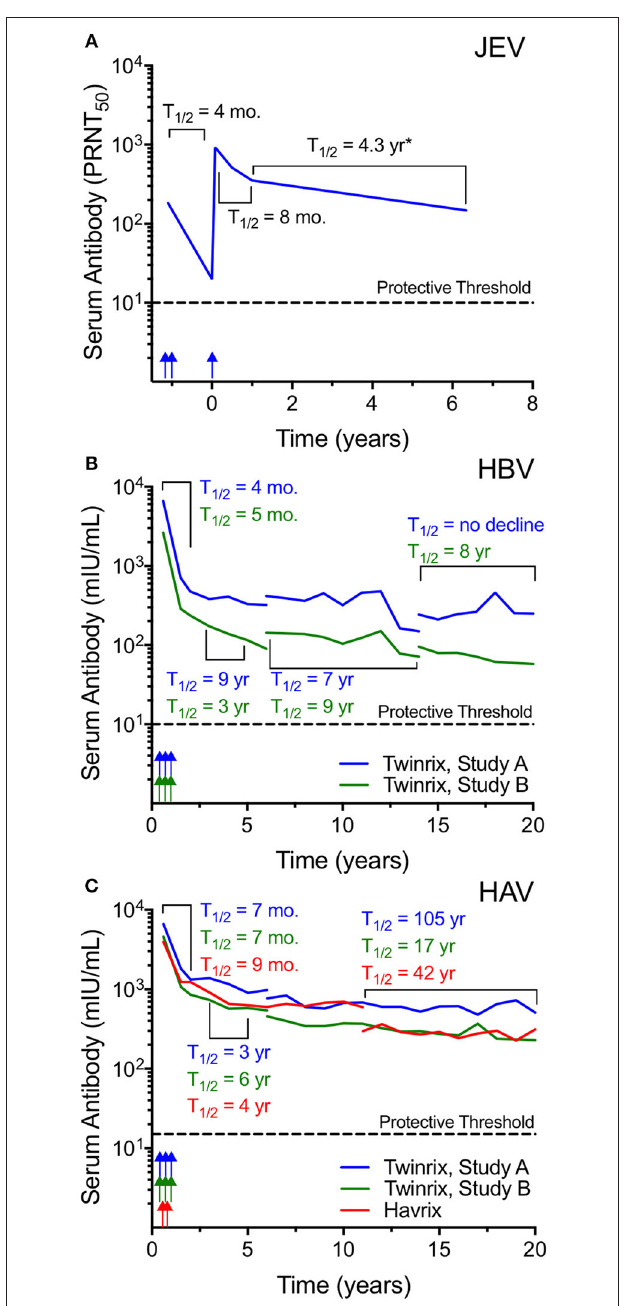
FIGURE 2 | Inactivated whole-virus vaccines induce long-lived antibody responses. (A) The alum-adjuvanted, inactivated whole-virus Ixiario ® JEV vaccine was used to immunize 67 subjects with a two-dose primary series spaced 28 days apart followed by a third dose administered at 15 months after the conclusion of the primary series. The figure was constructed using the primary data provided in Table 2 of Paulke-Korinek et al. (53). Serum samples were assessed for JEV-specific neutralizing activity (plaque-reduction neutralizing titer 50%; PRNT 50 ) for up to 6 years post-vaccination. The putative protective threshold of PRNT 50 ≥ 10 is shown as a dashed line. Vaccination time points are indicated by arrows. (B,C) Vaccine-induced serum antibody responses were monitored for up to 20 years in subjects receiving either a combined hepatitis B virus (HBV) and hepatitis A virus (HAV)